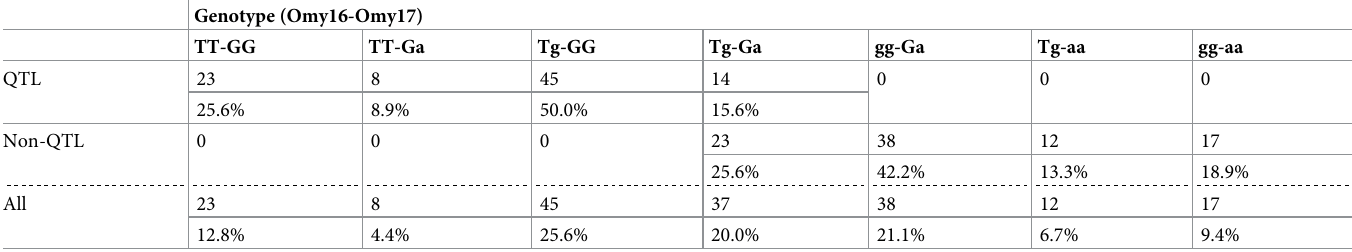
Table 1. Distribution of combined genotypes. The number of fish with a specific genotype and its percentage in the sampled population is shown. The upper and lower cases indicate favourite and non-favourite nucleotides related to discovered SNPs on Omy16 and Omy17. T and G are the favourite SNPs on Omy16 and Omy17, respec- tively. Thus, the first and last columns of genotype show the number of fish with double homozygote for favourite and non-favourite SNPs. The middle column (Tg-Ga) shows the double heterozygotes, the only genotype present in both QTL and non-QTL